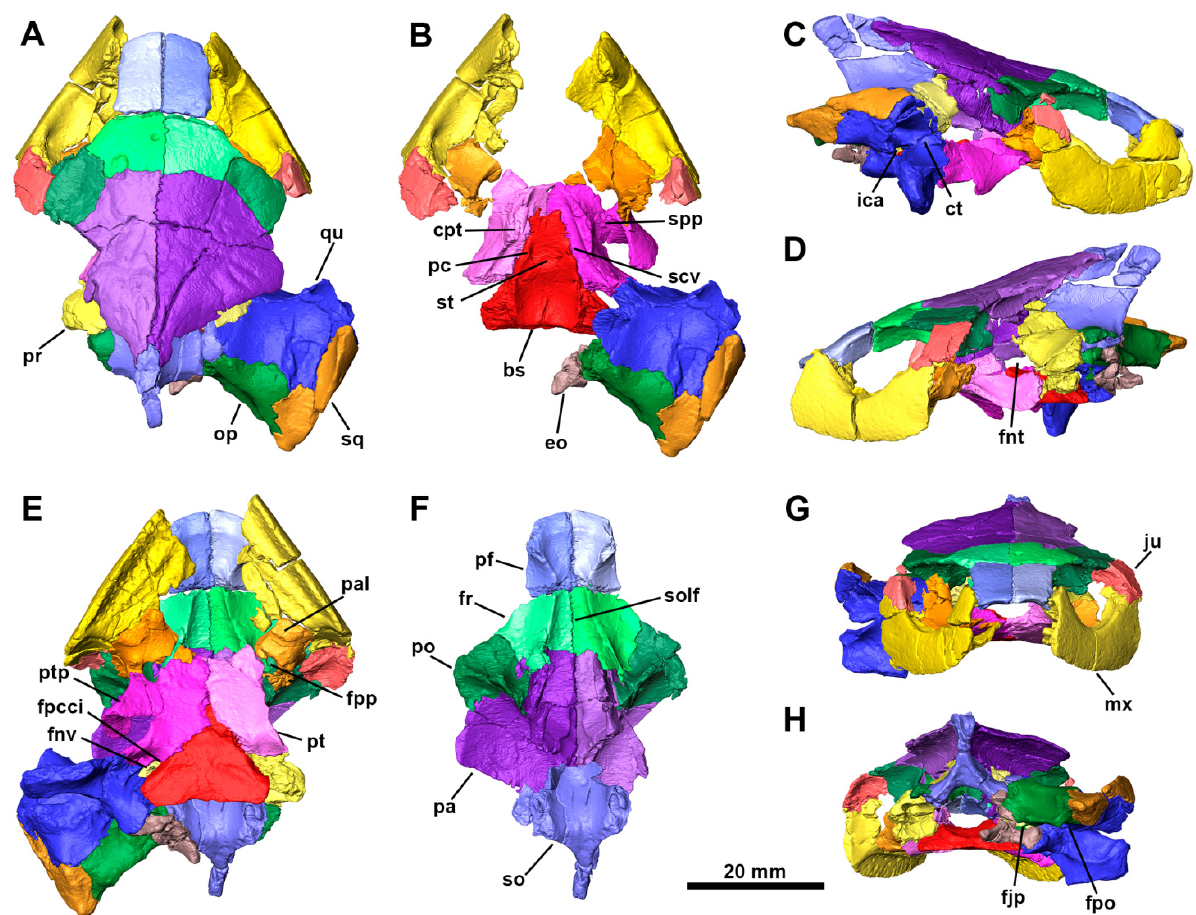
Figure 3. Virtual three-dimensional reconstruction of the specimen MNHN.F.SPP34, the paratype of Tartaruscola teodorii (Bothremydidae, Foxemydina), from the lower Ypresian (early Eocene) of Saint-Papoul (Aude, France), in which each bone is shown with a different color. The skull is presented in dorsal ( A , B ), right lateral ( C ), left lateral ( D ), ventral ( E , F ), anterior ( G ) and posterior ( H ) views. The bones of the cranial roof (prefrontals, frontals, parietals, postorbitals and supraoccipital) and prootics have been virtually removed in dorsal view ( B ) to show the dorsal surfaces of the palatal elements. All bones except the roof (prefrontals, frontals, parietals, postorbitals, and supraoccipital) have been virtually removed ( F ), to show the ventral view of that region. Abbreviations: bo, basioccipital; bs, basisphenoid; cpt, crista pterygoidea; ct, cavum tympani; eo, exoccipital; fjp, foramen jugulare posterius; fnt, foramen nervi trigemini; fnv, foramen nervi vidiani; fpcci, foramen posterius canalis caroticum internus; fpo, fenestra postotica; fpp, foramen palatinum posterius; fr, frontal; ica, incisura collumela auris; ju, jugal; mx, maxilla; op, opisthotic; pa, parietal; pal, palatine; pc, processus clinoideus; pf, prefrontal; pm, premaxilla; po, postorbital; pr, prootic; pt, pterygoid; ptp, processus trochlearis pterygoideus; qu, quadrate; scv, sulcus cavernosus; so, supraoccipital; solf, sulcus olfactorius; spp, sulcus palatinopterygoideus; sq, squamosal; st, sella turcica; vo, vomer.